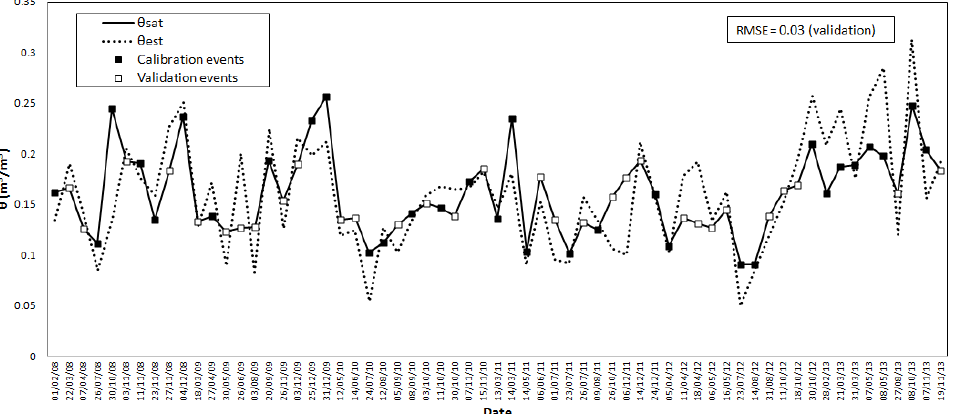
Figure 2. Time series of satellite-derived and estimated (through the SWBM) soil moisture at the beginning of 63 erosive events in the study period